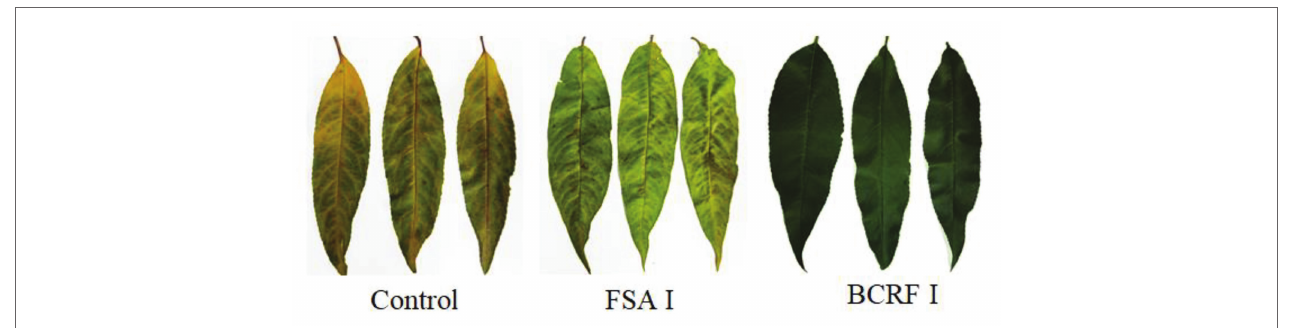
FIGURE 3 | Phenotype of peach leaves under different fertilization modes.